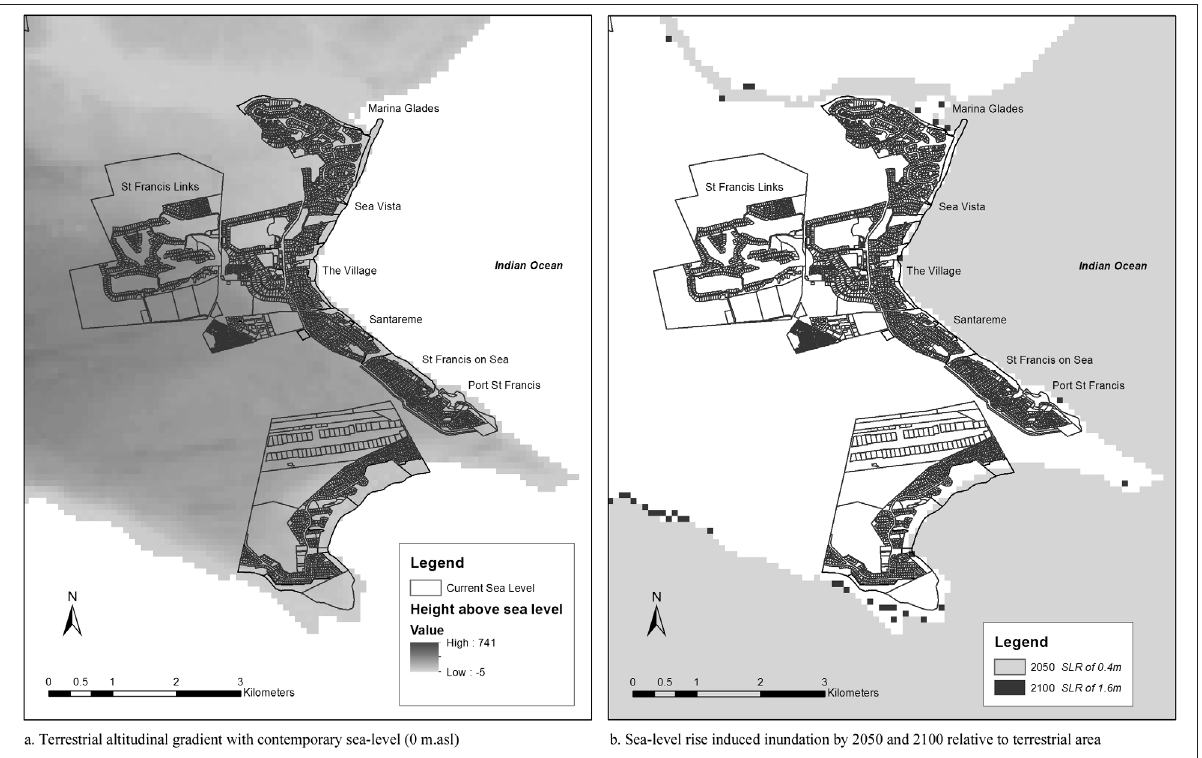
Figure 4: Digital elevation model illustrating predicted sea-level rise for both towns for the years 2050 and 2100. (a) Terrestrial altudinal gradient with contemporary sea level (0 masl) and (b) sea-level rise (SLR) induced inundation relative to terrestrial